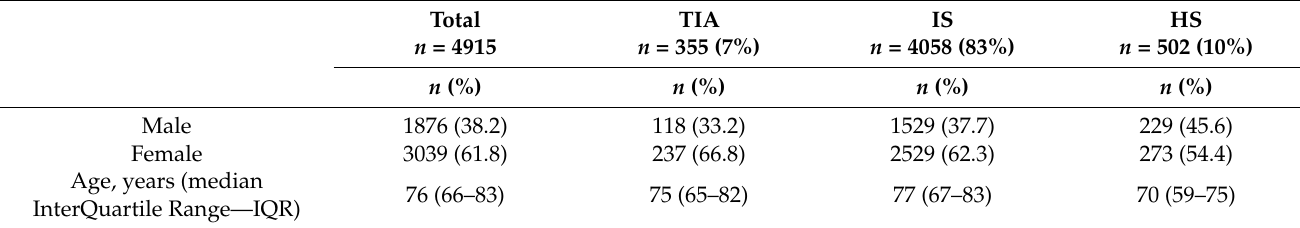
Table 1. Characteristics of the patients with transient ischemic attack (TIA), ischemic stroke (IS), and hemorrhagic stroke (HS).